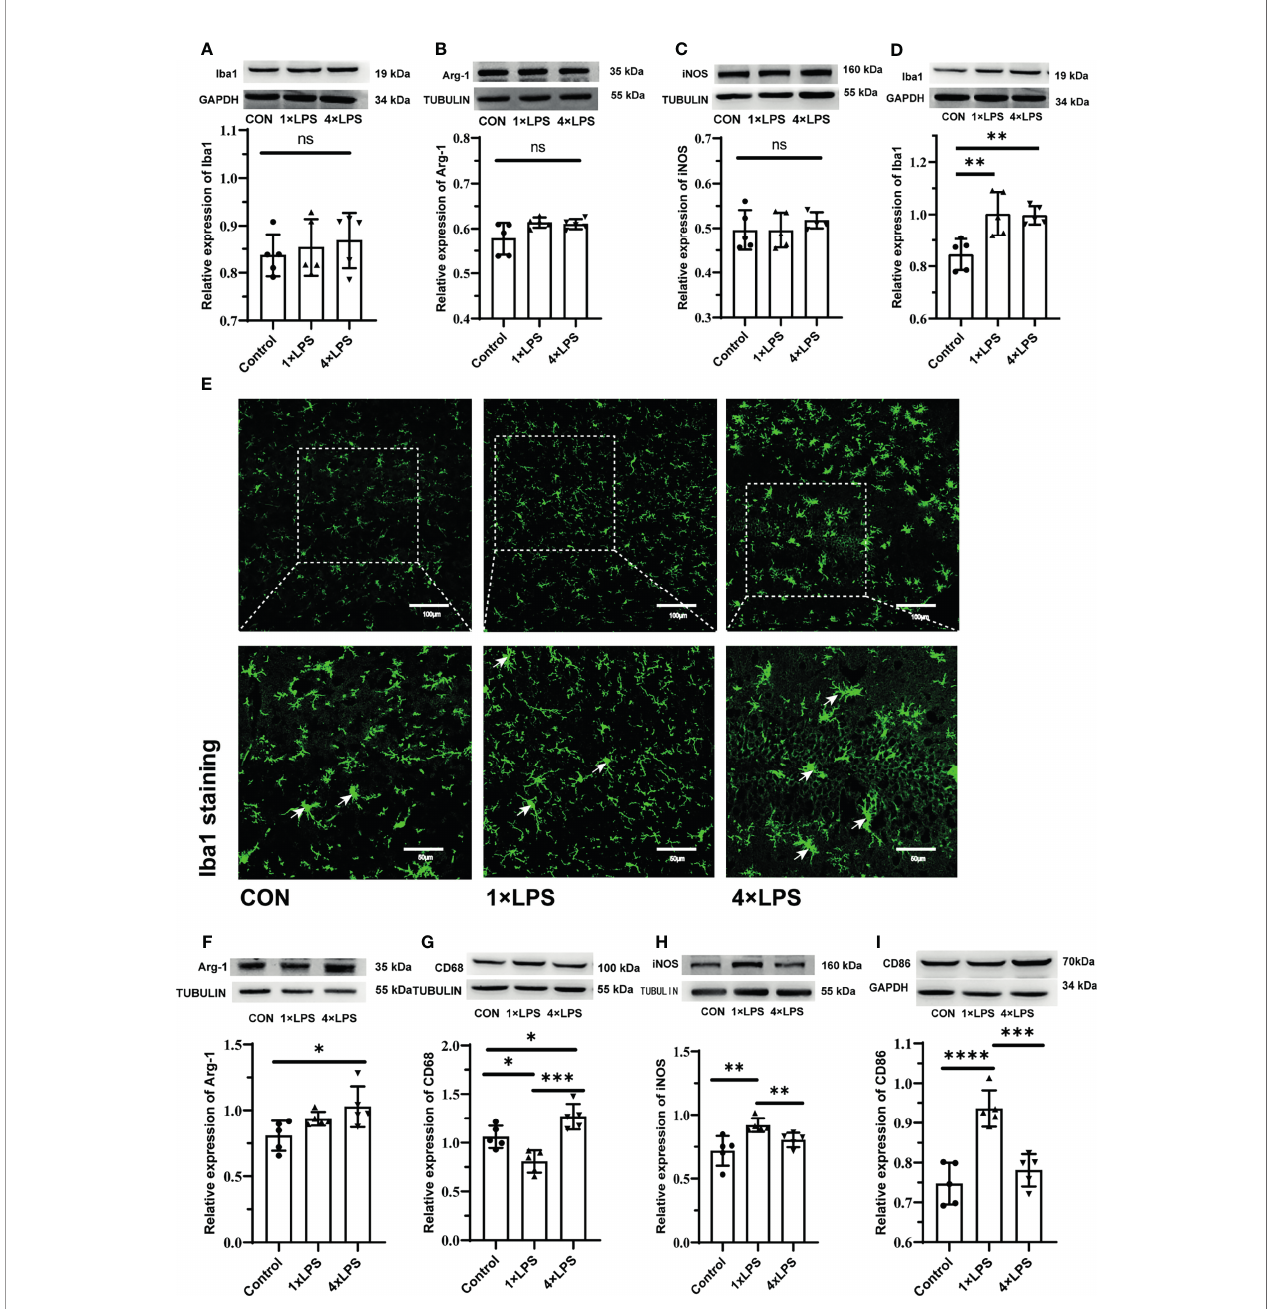
FIGURE 5 | Figures (A – C) show the expression and differentiation of microglia before epilepsy modeling. (A) Western blot showing protein expression of Iba1 protein. Data are expressed as the mean ± SEM (n = 5 per group). (B) Western blot showing protein expression of Arg-1 protein. Data are expressed as the mean ± SEM (n = 5 per group). (C) Western blot showing protein expression of iNOS protein. Data are expressed as the mean ± SEM (n = 5 per group). Figures (D – I) show the expression and differentiation of microglia 24 hours after epilepsy modeling. (D) Western blot showing protein expression of Iba1 protein. Data are expressed as the mean ± SEM (n = 5 per group). (E) Iba1 positive cells (green; Alexa Fluor-488 staining) were observed with fl uorescence microscope. White arrows indicate Iba1 positive cells. Scale bars: 100 m m for 200×, 50 m m for 400×. (F) Western blot showing protein expression of Arg-1 protein. Data are expressed as the mean ± SEM (n = 5 per group). (G) Western blot showing protein expression of CD68 protein. Data are expressed as the mean ± SEM (n = 5 per group). (H) Western blot showing protein expression of iNOS protein. Data are expressed as the mean ± SEM (n = 5 per group). (I) Western blot showing protein expression of CD86 protein. Data are expressed as the mean ± SEM (n = 5 per group). ns, no signi fi cance. *P < 0.05; **p < 0.01; ***p < 0.001; ****p < 0.0001 by one-way ANOVA (and nonparametric or mixed) followed by methods of multiple